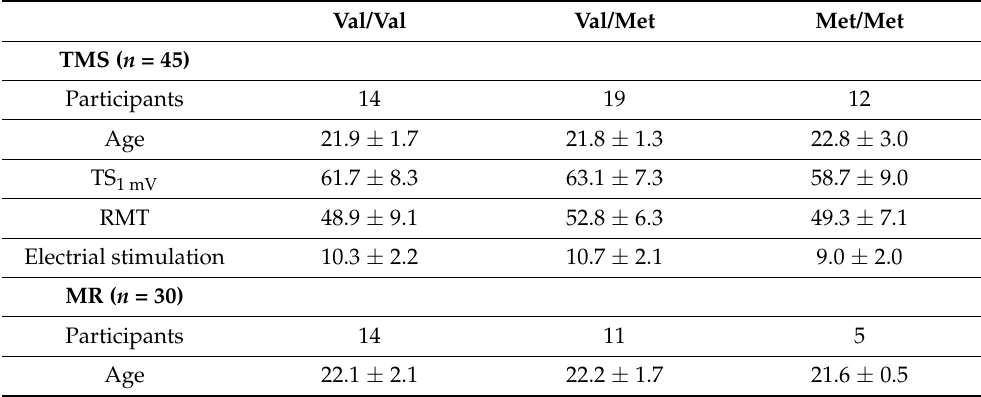
Table 1. Participant information and TMS settings by BDNF genotype in TMS and MR experiments. Val/Val Val/Met